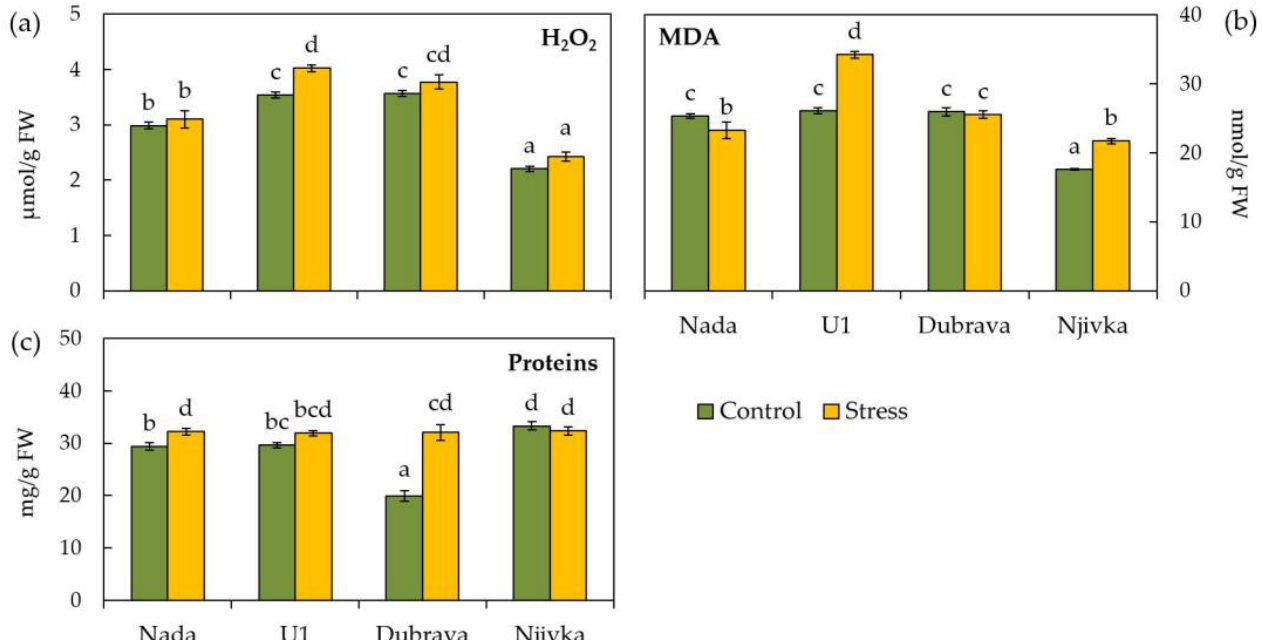
Figure 2. Hydrogen peroxide ( a ), malondialdehyde (MDA) ( b ), and proteins content ( c ) in control and drought stressed flag leaves of wheat cultivars. Bars represent mean values ± SE. Different letters indicate significant difference among treatments and cultivars at p < 0.05 according to LSD test.